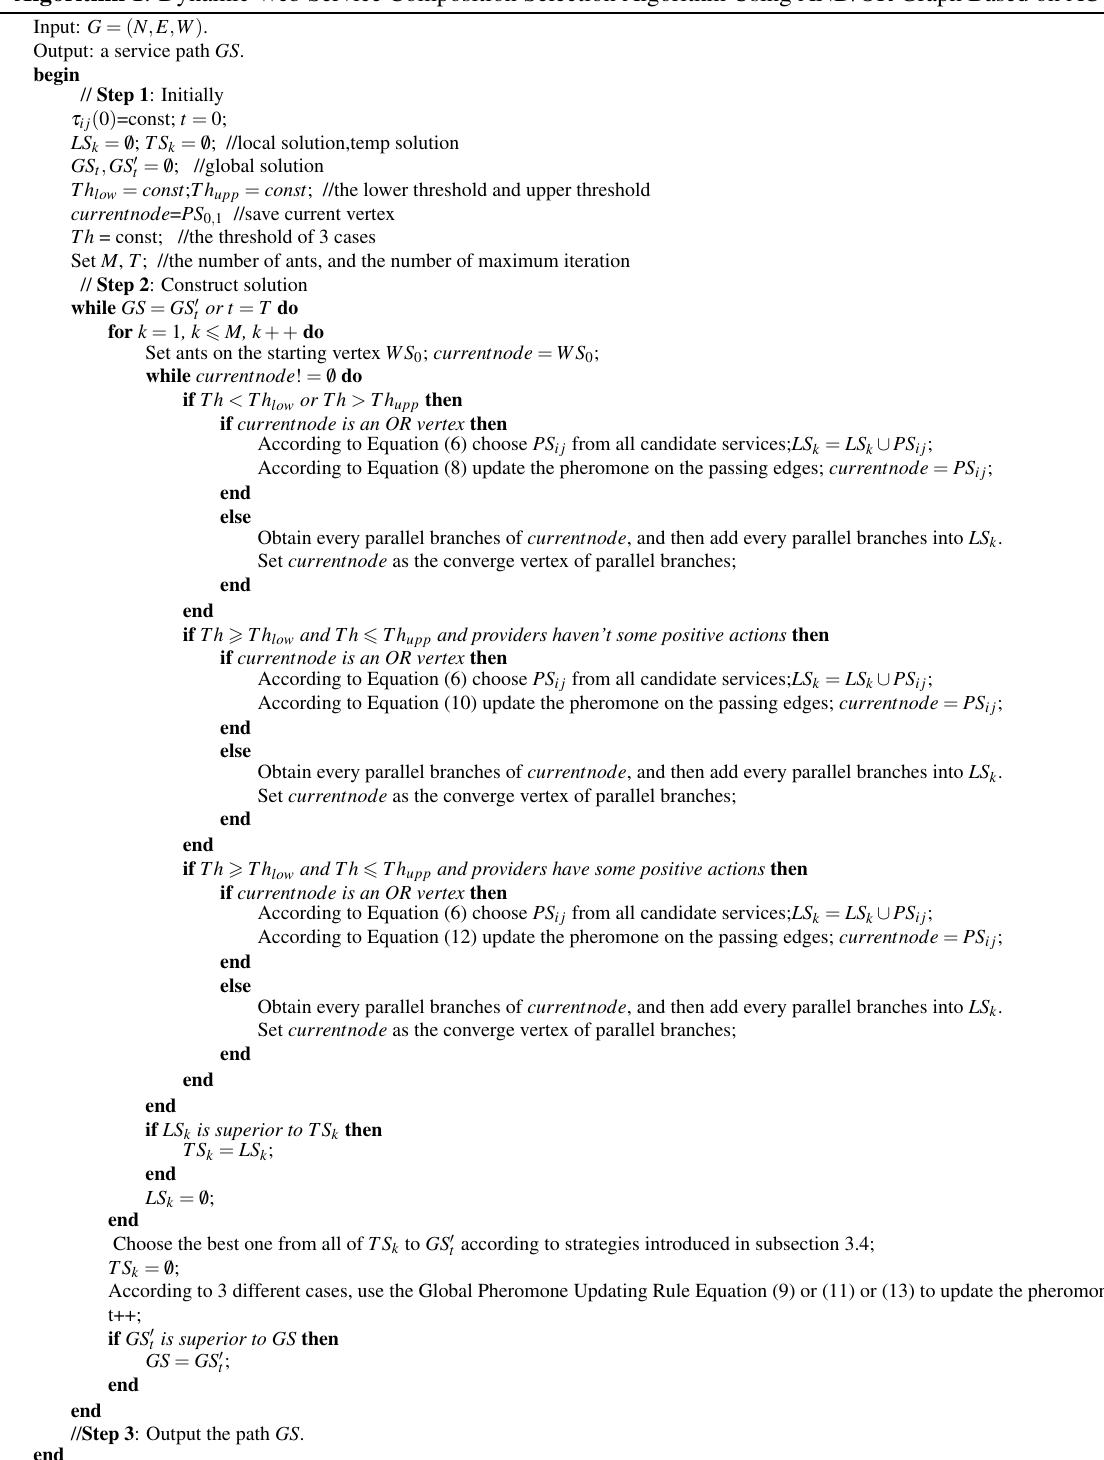
Algorithm 1 : Dynamic Web Service Composition Selection Algorithm Using AND/OR Graph Based on